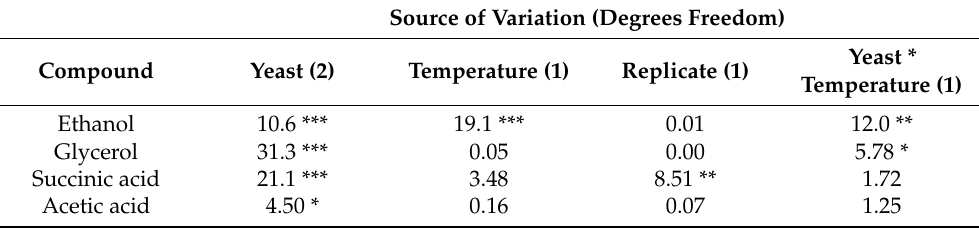
Table 2. Significance and F ratios from analysis of variance of chemical composition of Merlot wines inoculated with or without non- Saccharomyces yeasts followed by S. cerevisiae . Source of Variation (Degrees